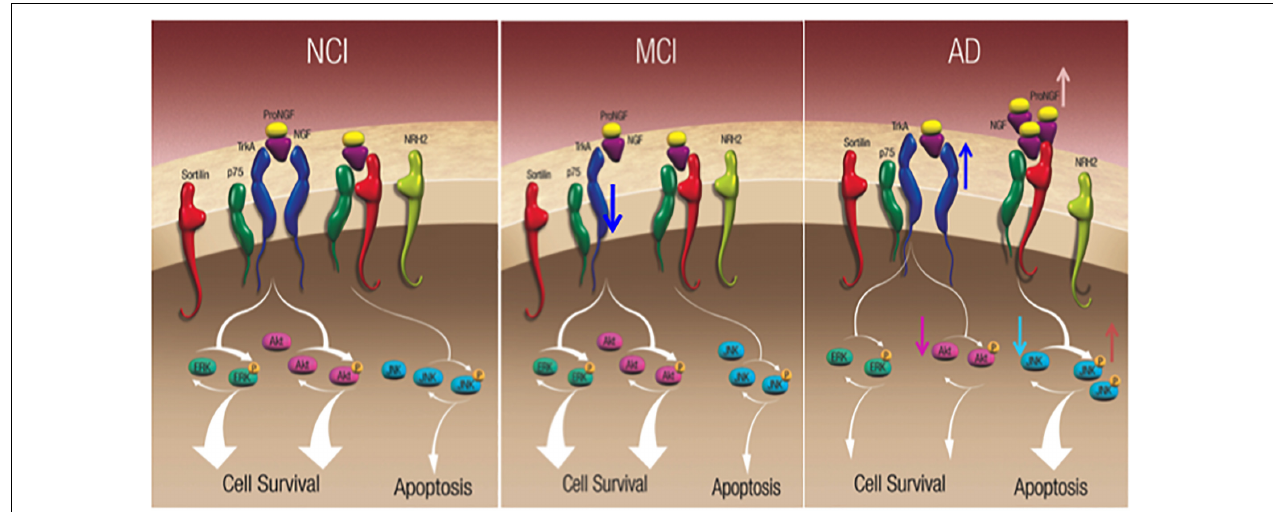
FIGURE 8 | Schematic diagrams showing alteration in hippocampal neurotrophic protein levels during the progression of AD. Reproduced from Mufson et al.